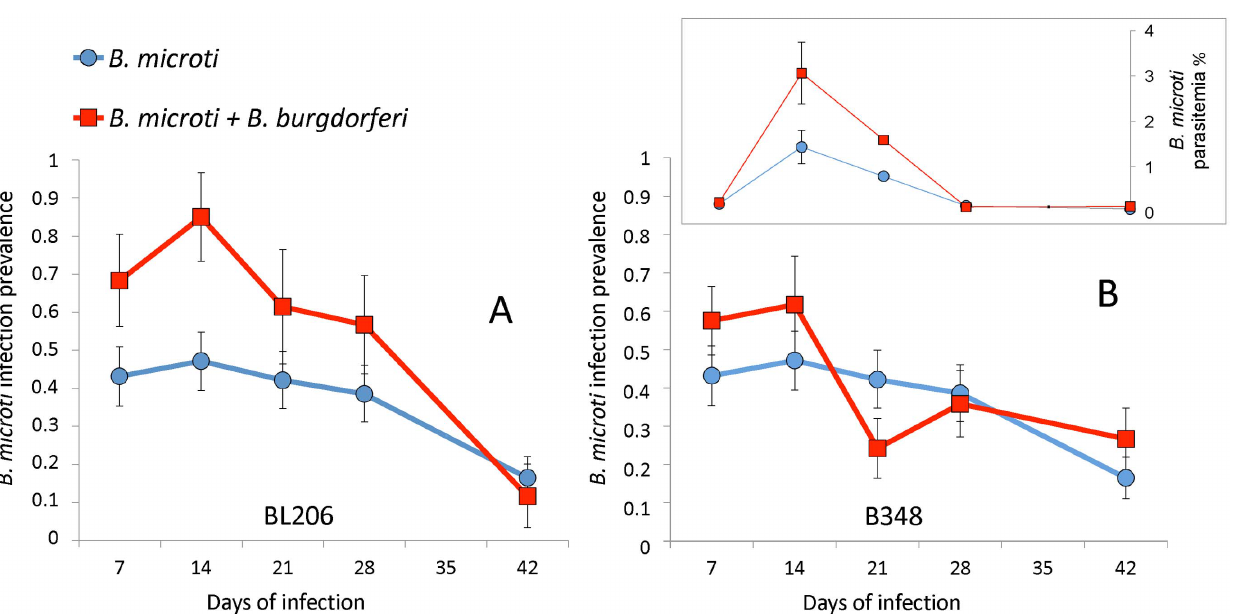
Fig 3. Effect of coinfection on larval acquisition of Babesia microti . The results show the prevalence of B. microti in xenodiagnostic ticks that fed on mice infected with B. microti alone compared to mice coinfected with B. microti and Borrelia burgdorferi strain BL206 (A) or B. burgdorferi strain B348 (B). B. microti parasitemia in mice infected with B. microti alone or B. microti and B. burgdorferi strain B348 are shown in inset above B. The error bars indicate 95% confidence